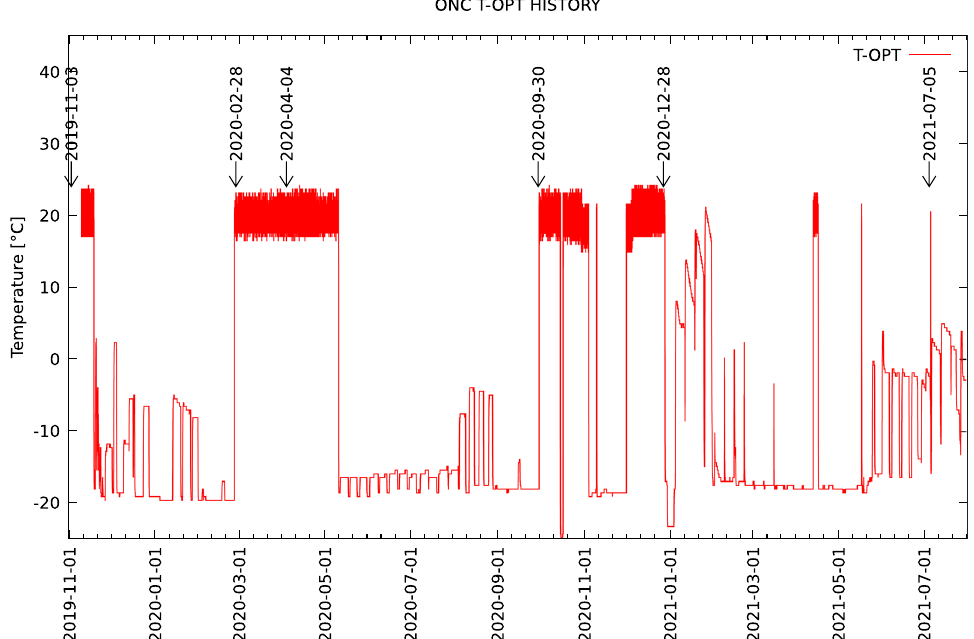
Fig. 6 Optics temperature history for ONC-T from November 2019 to July